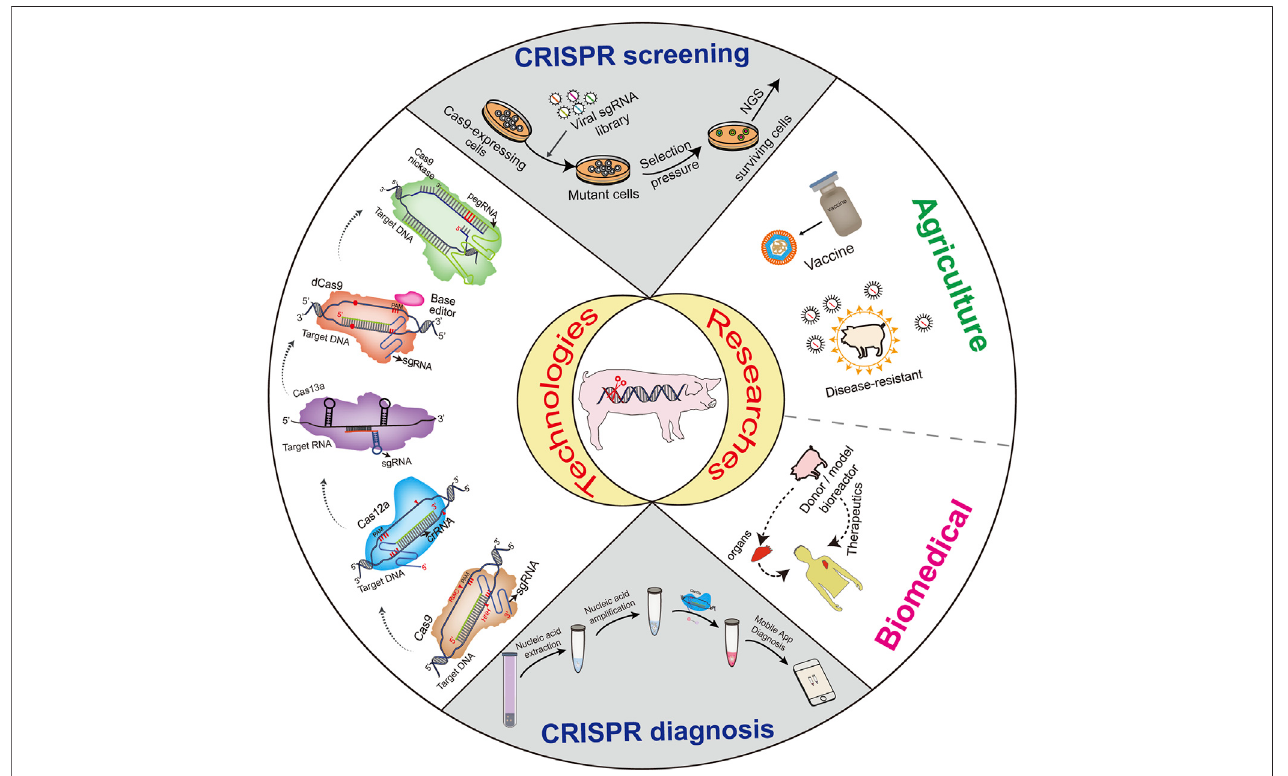
FIGURE 1 | The CRISPR system and its